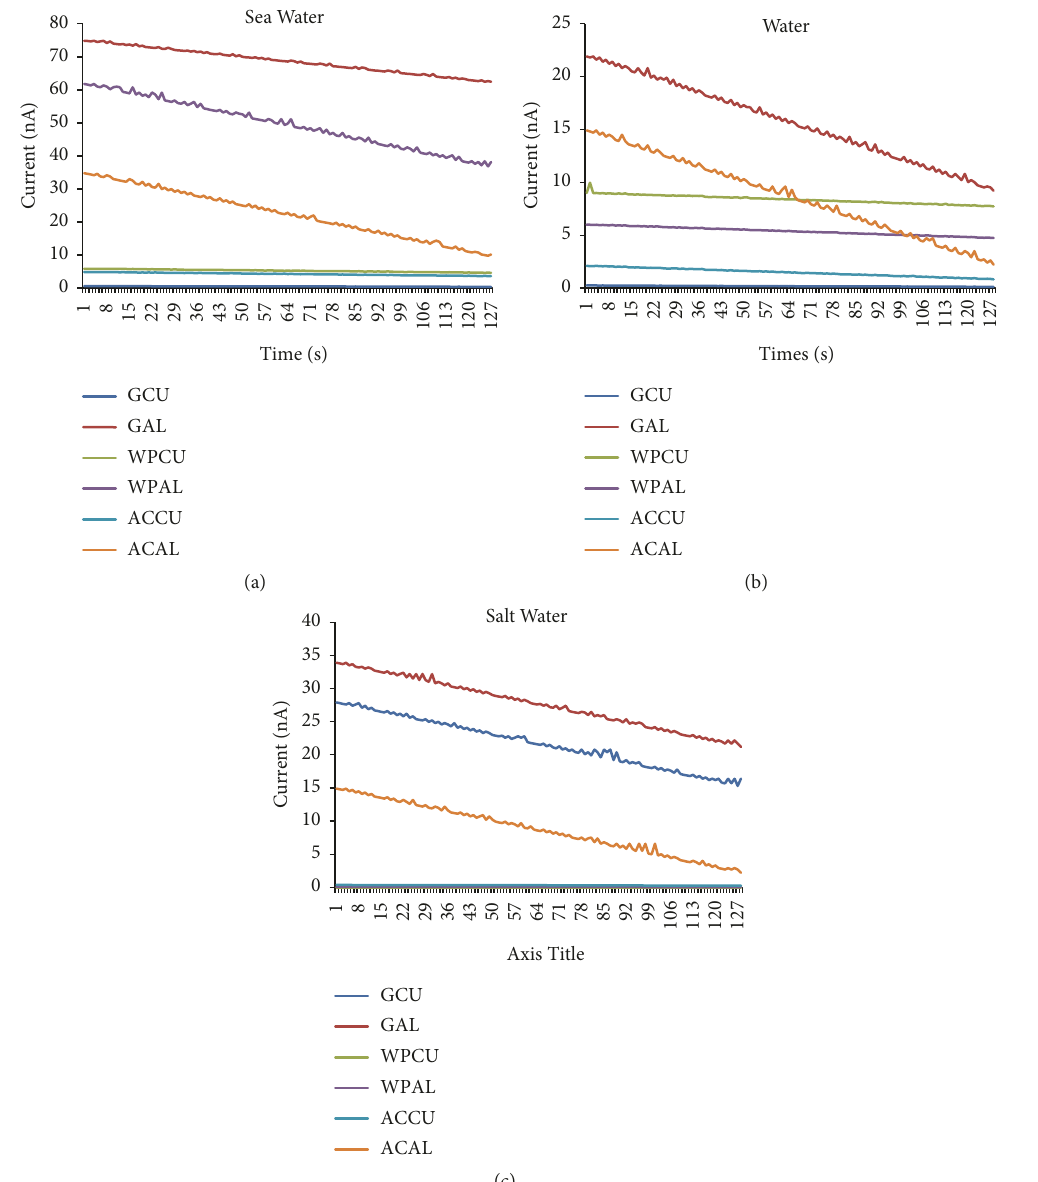
Figure 8: (a) Response of current of sea water. (b) Response of current of water (H 2 O). (c) Response of current of salt